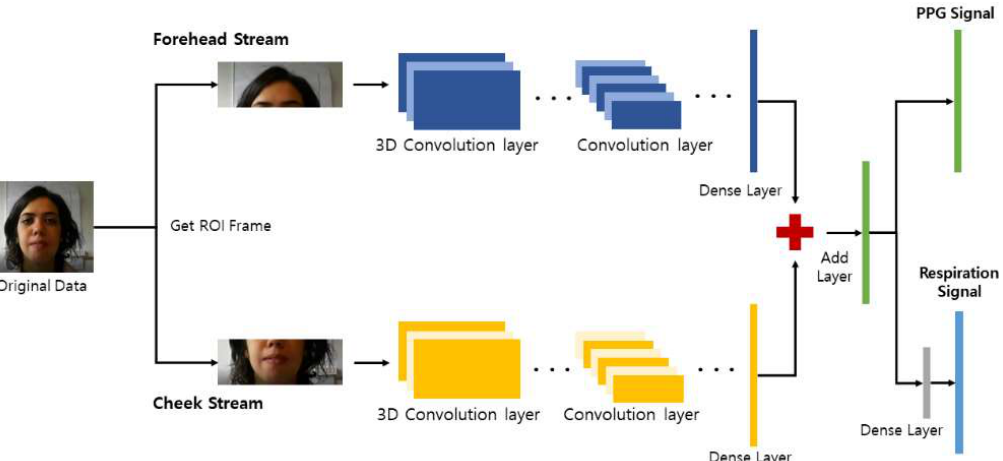
Figure 1. Multitask Siamese (MTS) network architecture. The forehead and cheeks are extracted as regions of interest (ROIs) from the facial image, which enter the weighted networks as forehead and cheek streams, respectively. Cardiac (photoplethysmography (PPG)) signals can be obtained based on the value from the last layer of the Siamese network, and the respiratory signal is estimated after an additional dense layer in the last part of the Siamese network.